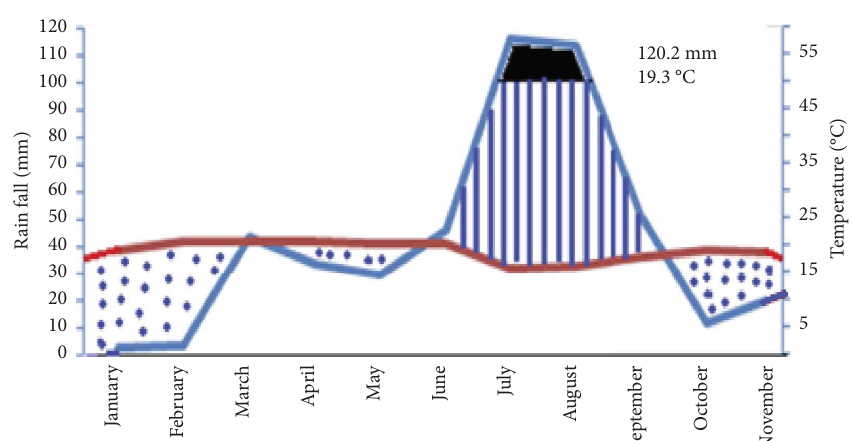
Figure 2: Average rainfall and temperature data of 10 years (2009–2018) of Wadla District modifed using the 2020 National Meteorological Data of Kombolcha